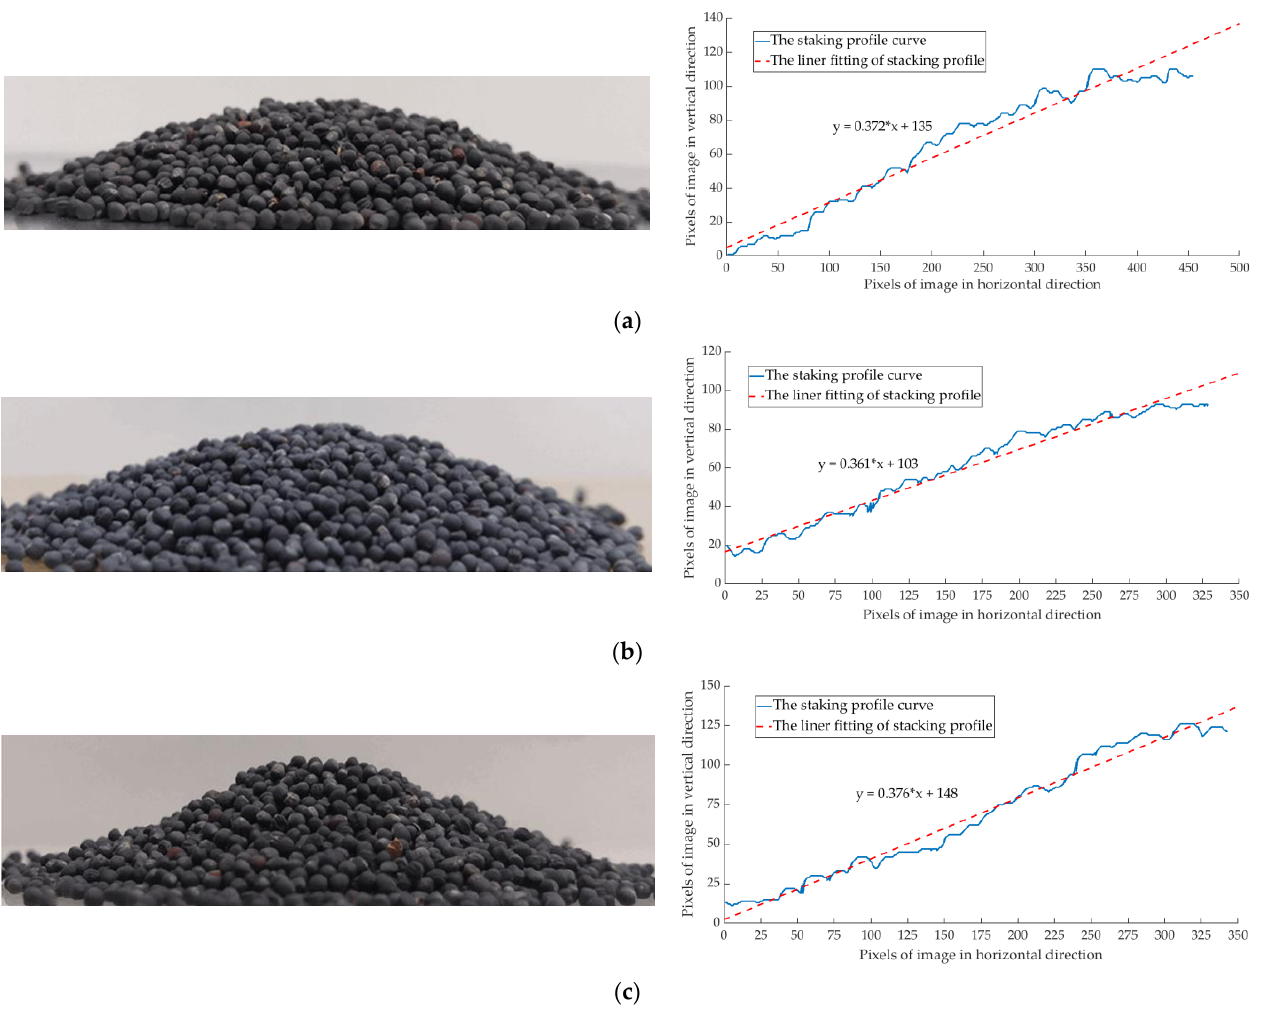
Figure 9. Comparison of simulation results with real test results, ( a ) Accumulation of rapeseed on aluminum alloy plate; ( b ) Accumulation of rapeseed on acrylic plate; ( c ) Accumulation of rapeseed on high-density polyethylene plate.